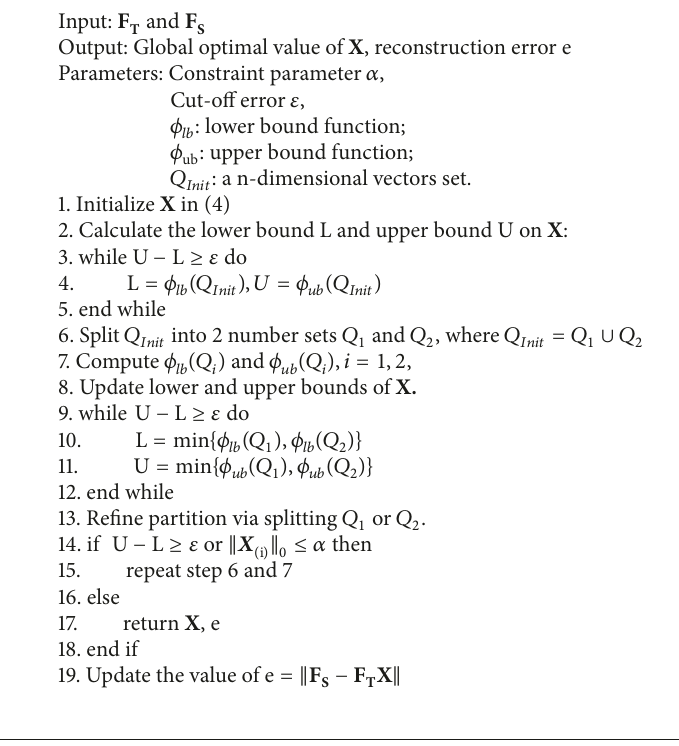
Algorithm 1: Branch and Bound optimized Domain